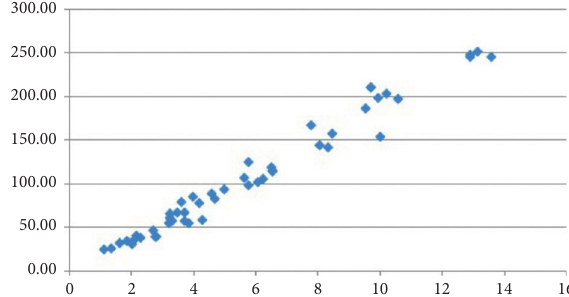
Figure 5: The estimated improvement (in seconds) depending on the articles’ lengths (in